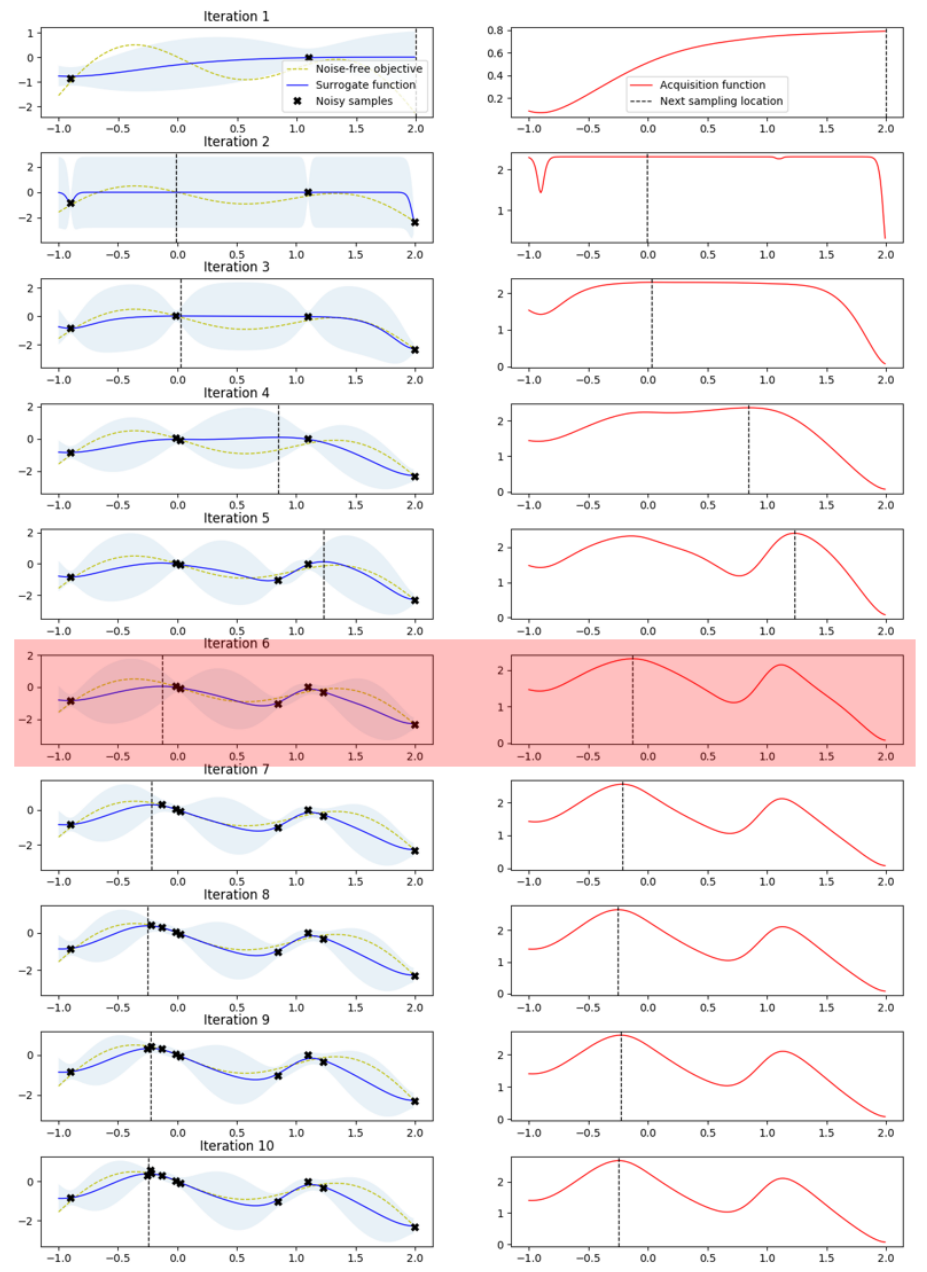
Figure 4. Tested of Gaussian Process with Gaussian